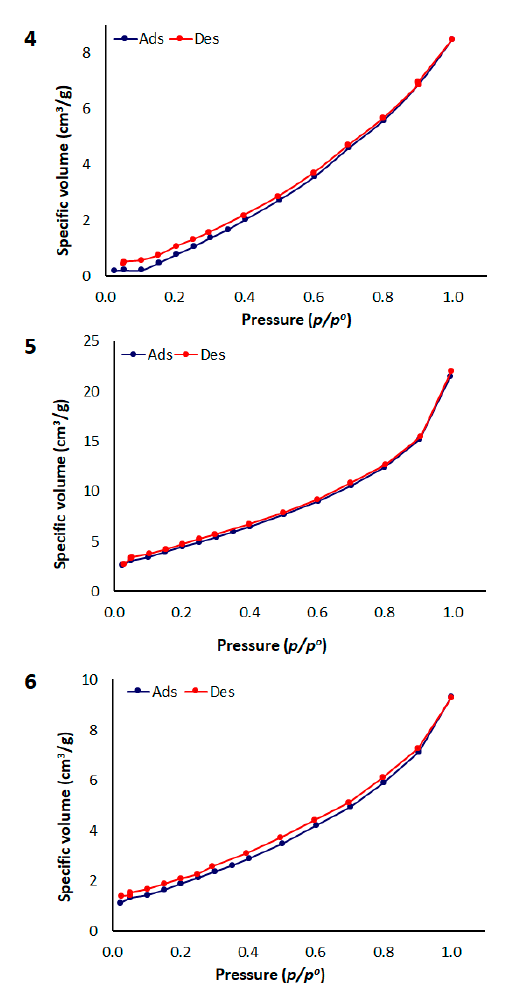
Figure 4. N 2 adsorption–desorption of polymers 4–6 .